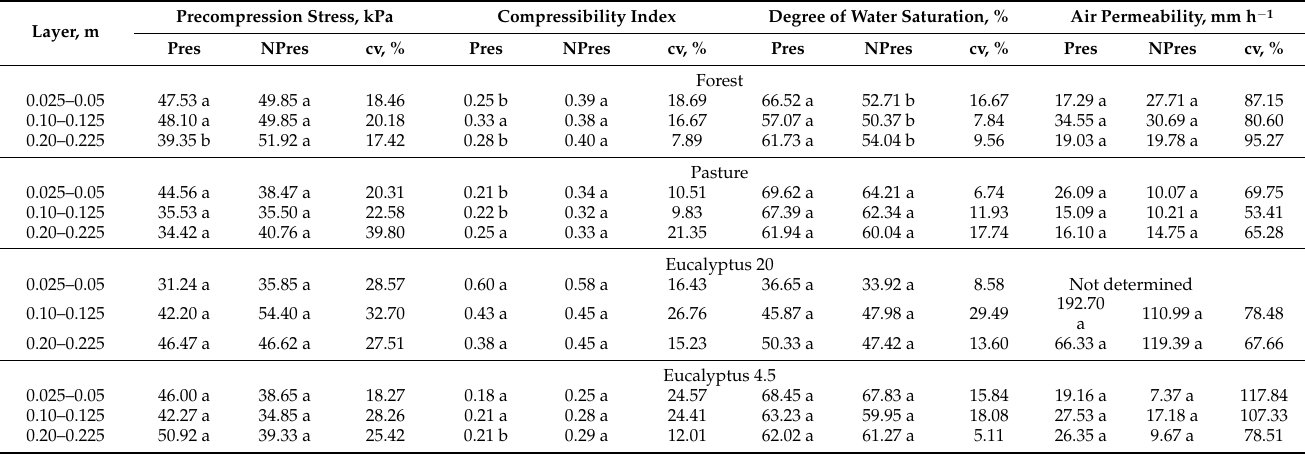
Table 4. Coefficient of variation (cv) and average values of precompression stress, compressibility index, degree of water saturation and air permeability for soil with preserved (Pres) and non- preserved (NPres) structure under different land uses and layers.